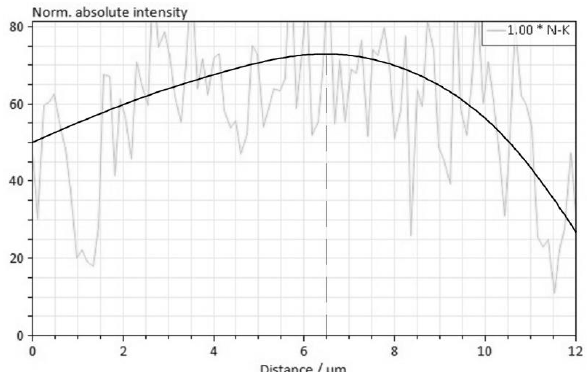
Fig. 5. Change of nitrogen concentration inwards from the surface of sample